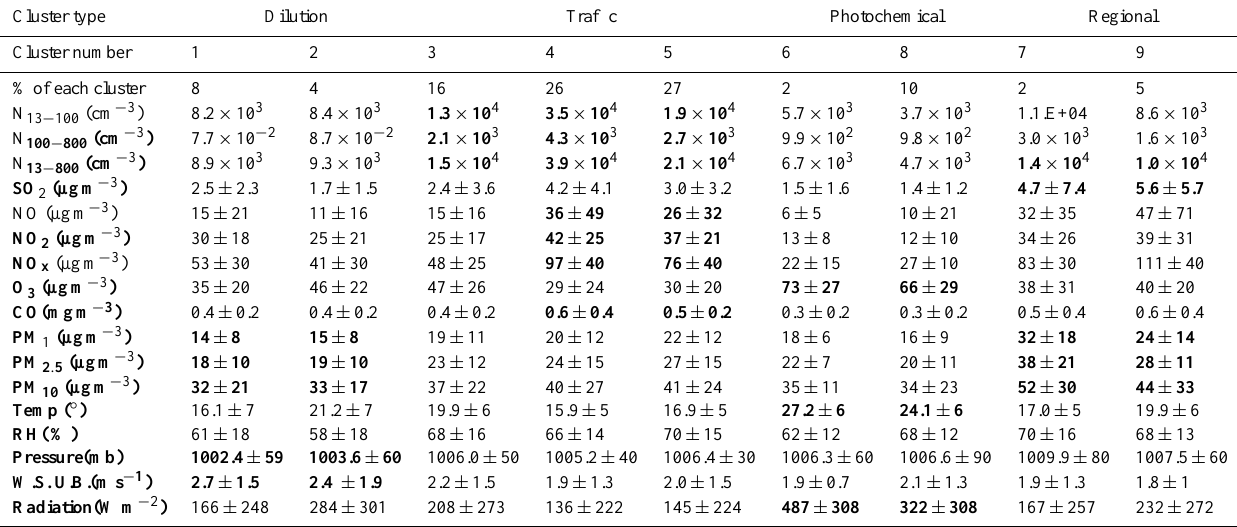
Table 2. Average values associated to each of the nine DMPS clusters. Bold text are for particularly low and-or high values. Cluster type Dilution Traffic Photochemical Regional